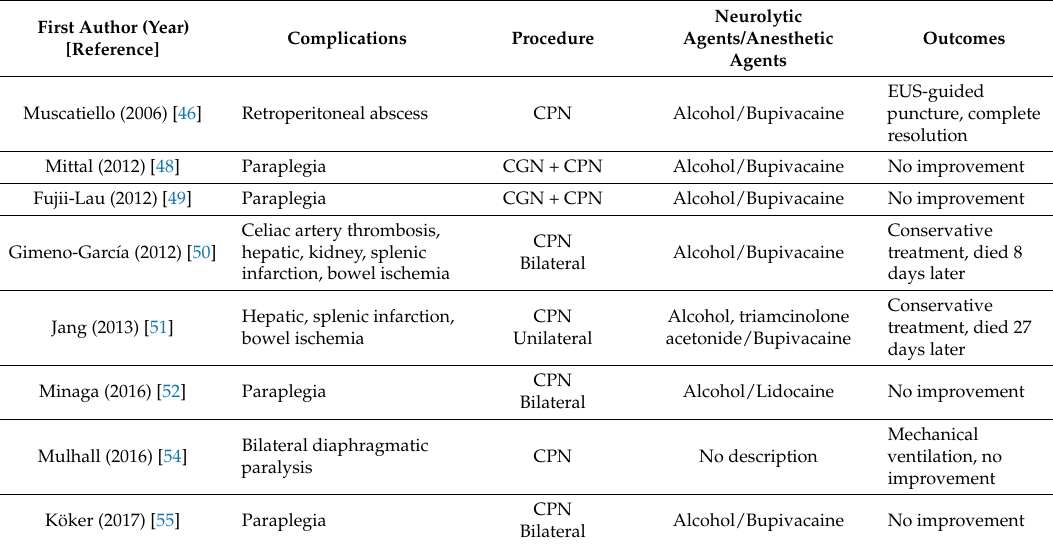
Table 2. Major complications of EUS-guided neurolysis in pancreatic